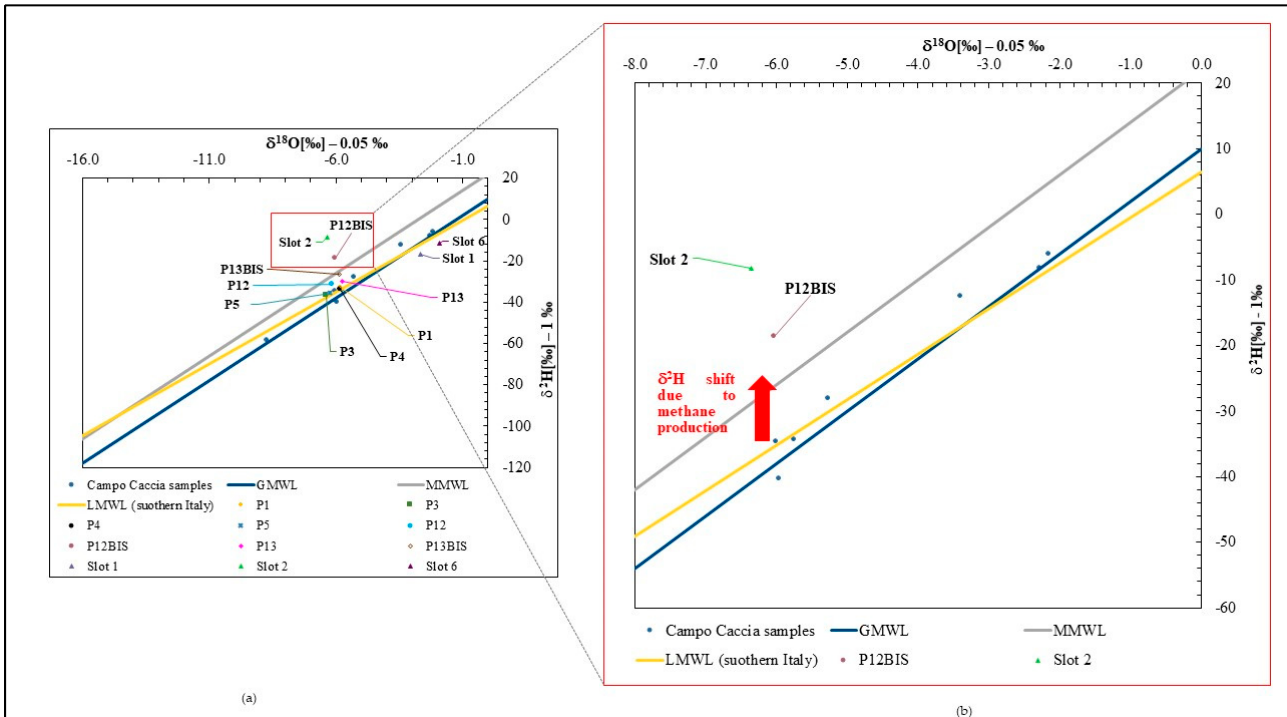
Figure 4. δ 2 H vs. δ 18 O values for Case History I: all samples ( a ) and Slot 2 & P12bis ( b ).